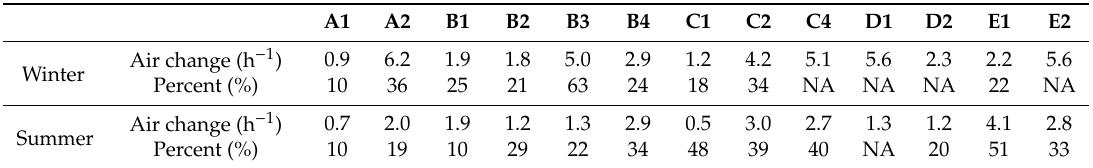
Table 8. Test results of infiltration